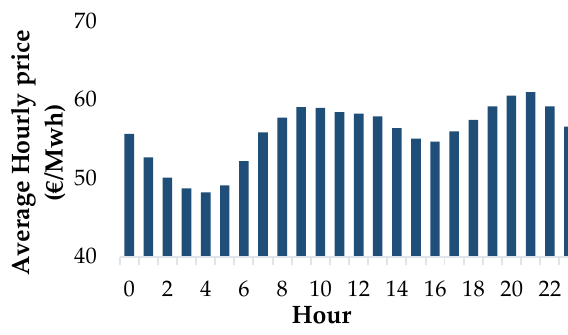
Figure 2. Average hourly price of electricity.